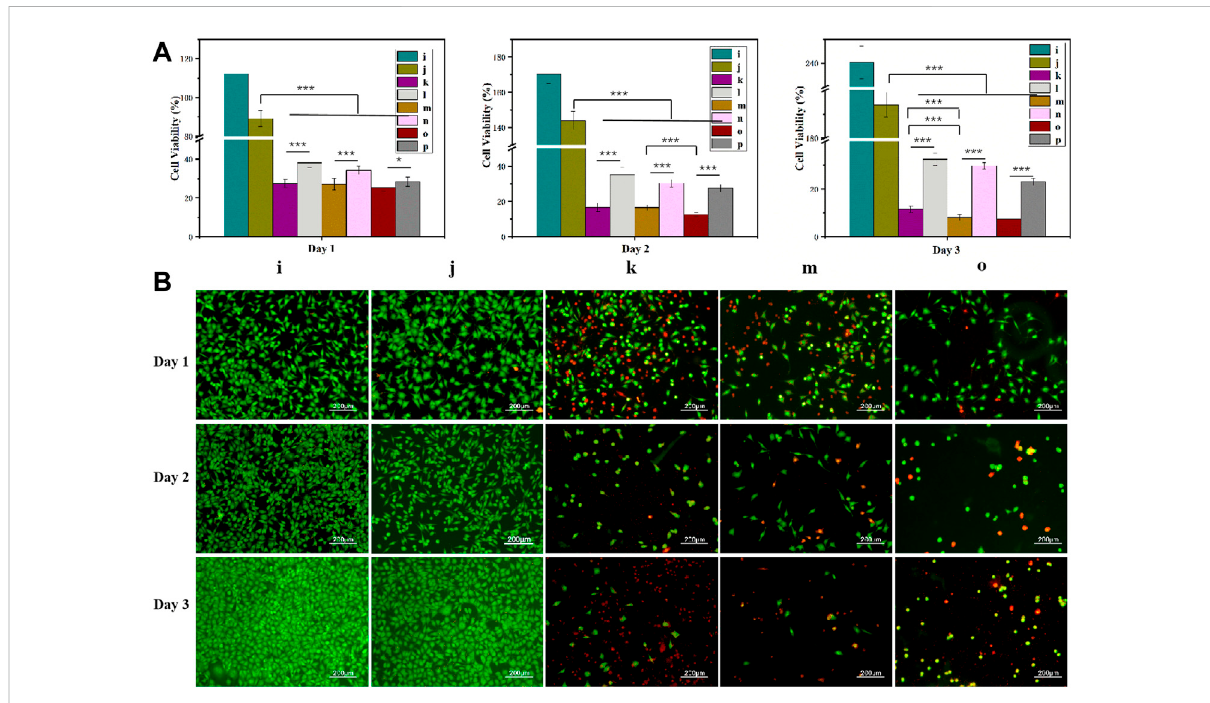
FIGURE 9 MCF-7cellviabilitymeasuredusingtheCCK-8assay (A) andAO/EBstaining (B) .i:Blank;j:CSSHgelsk:Cur – Lip/Dox/CSSHgels(100 μ M/50 μ